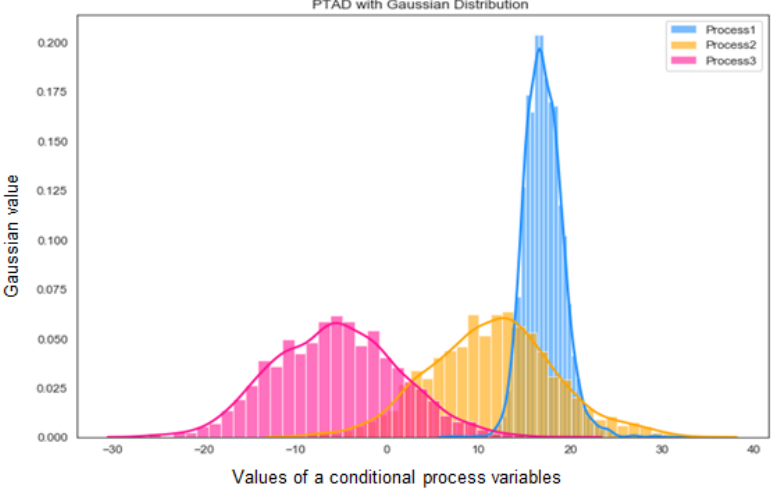
Figure 10. Results of multiple process trajectories of abnormal detection in real-world manufacturing process.